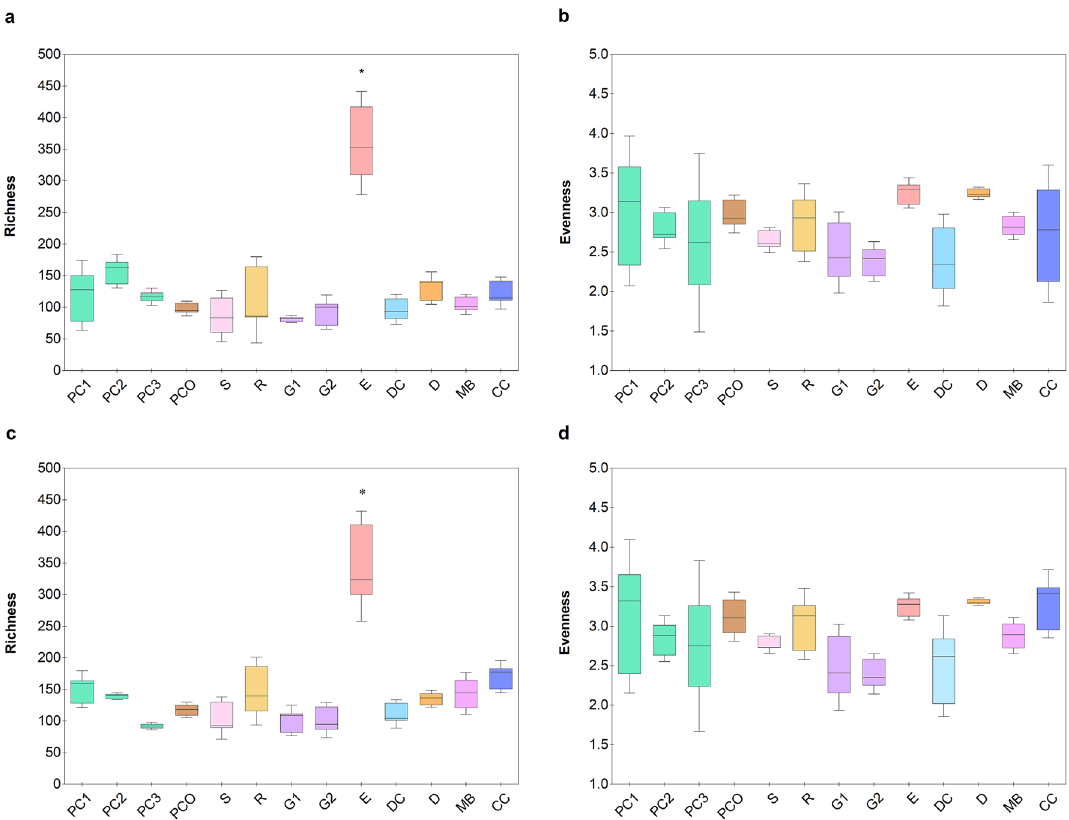
Figure 2. Alpha diversity measurements of OTU compositions at ( a , b ) genus and ( c , d ) species levels, by richness (Chao) and evenness (Shannon). Box plot with bar representing the mean from three sequencing replicates, and asterisk (*) indicates a statistically significant difference by one-way ANOVA at p <